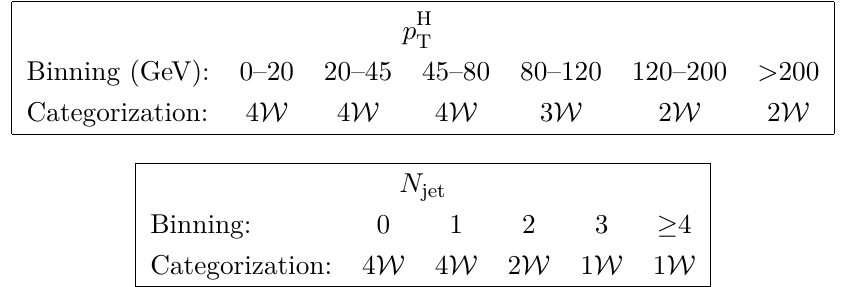
Table 2 . Binning of the DO and signal categorizations used in the respective bins.